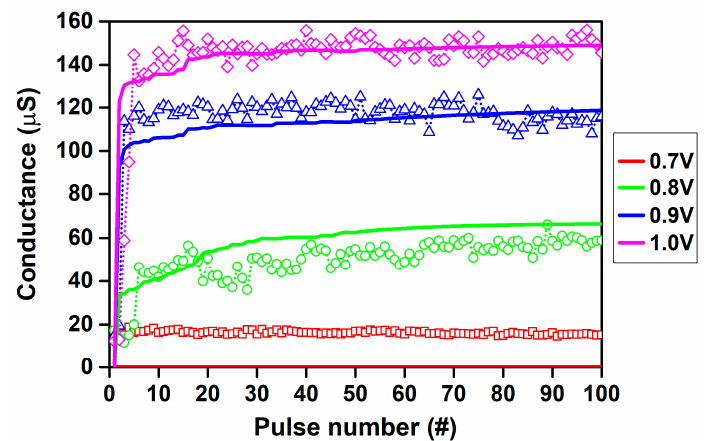
Figure 7. Experimental (symbols) and simulated (lines) conductance evolution of TiN / 6 nm HfO x / TiO y / TiN RRAM stacks under the application of set pulse trains with a 1 ms width and variable amplitude: (red) 0.7 V; (green) 0.8 V; (blue) 0.9 V; (magenta) 1.0 V. Initial forming was performed with a 100 µA compliance current.